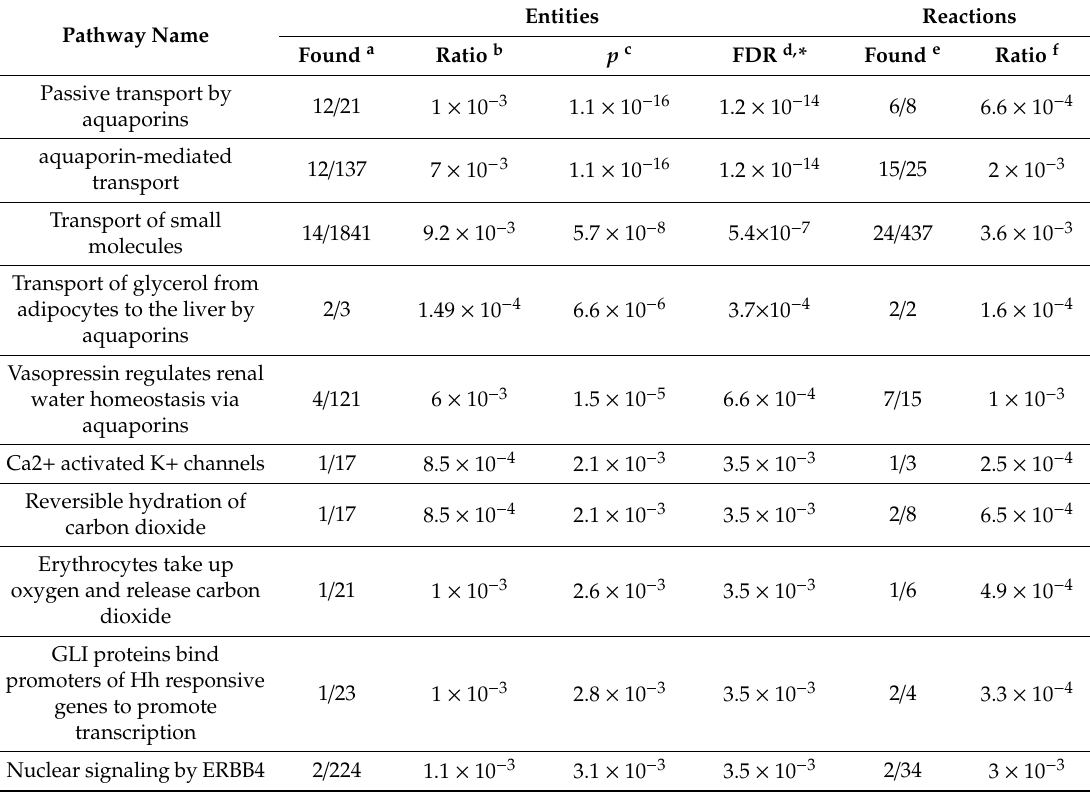
Table 6. Pathway enrichment analysis for genes of the age at first calving network. The following table shows the 10 most relevant pathways sorted by p